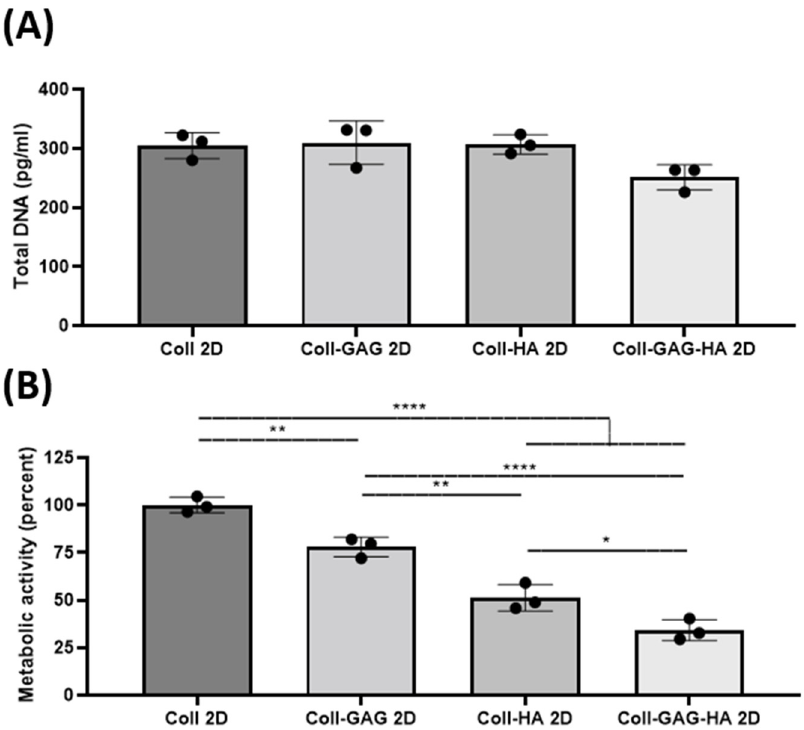
Figure 2. Changes in biological activity of MLO-Y4 cells cultured on different 2D film substrate compositions: Collagen-1 (Coll 2D), Collagen-1 + Chondroitin Sulphate (Coll-GAG 2D), Collagen-1 + Hydroxyapatite (Coll-HA 2D), Collagen-1 + Chondroitin Sulphate + Hydroxyapatite (Coll-GAG-HA 2D). ( A ) Proliferation as measured by DNA content. ( B ) Metabolic Activity as measured by MTS assay. ( n = 3; * p < 0.05; ** p < 0.01, **** p <